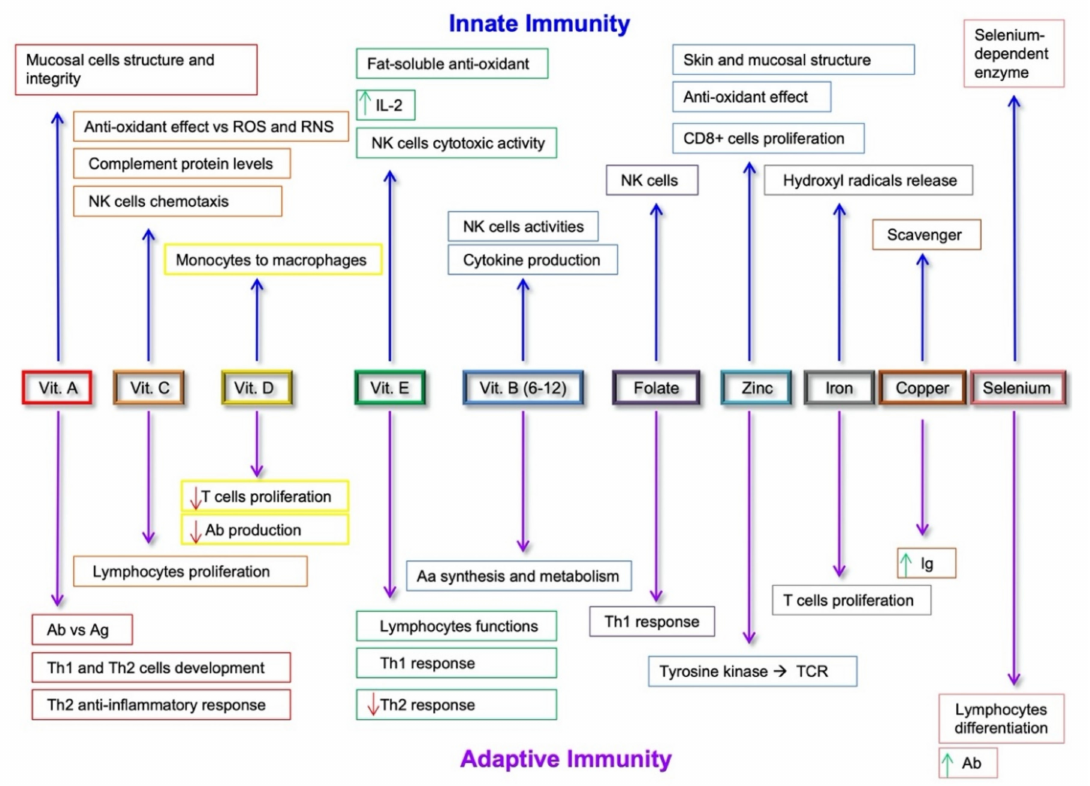
Figure 2. Effects of micronutrients on the modulation of innate and adaptive immunity systems. Abbreviations: ROS, Reactive Oxygen Species; RNS, Reactive Nitrogen Species; NK, Natural Killer; Ab, Antibodies; Ag, Antigens; Aa, Amino Acids; Ig, Immunoglobulins; TCR, T Cell Receptor. Green up arrows: upregulation; Red down arrows: